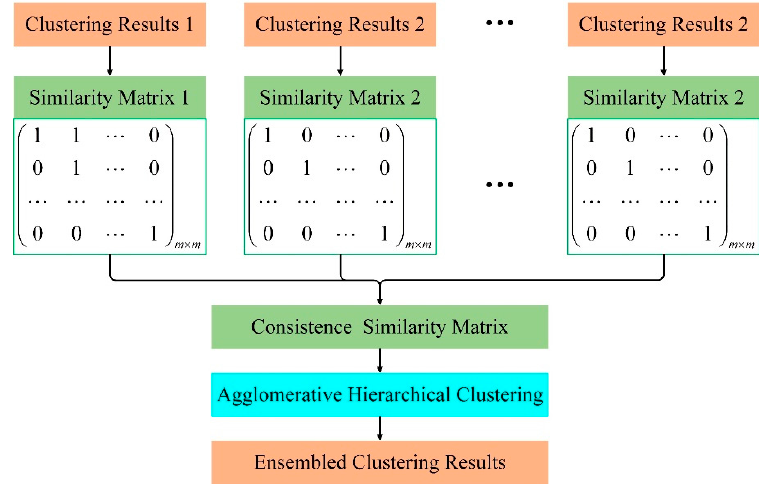
Figure 5. Flow chart of clustering ensemble based on a similarity matrix.